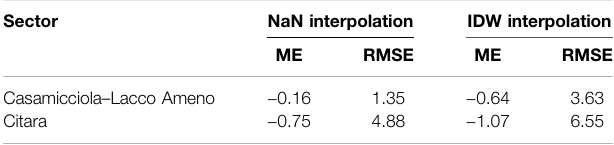
TABLE 1 | Cross-validation results for NaN and IDW interpolation methods during the dry season. The mean prediction error (ME) and root-mean-square prediction error (RMSE) are in